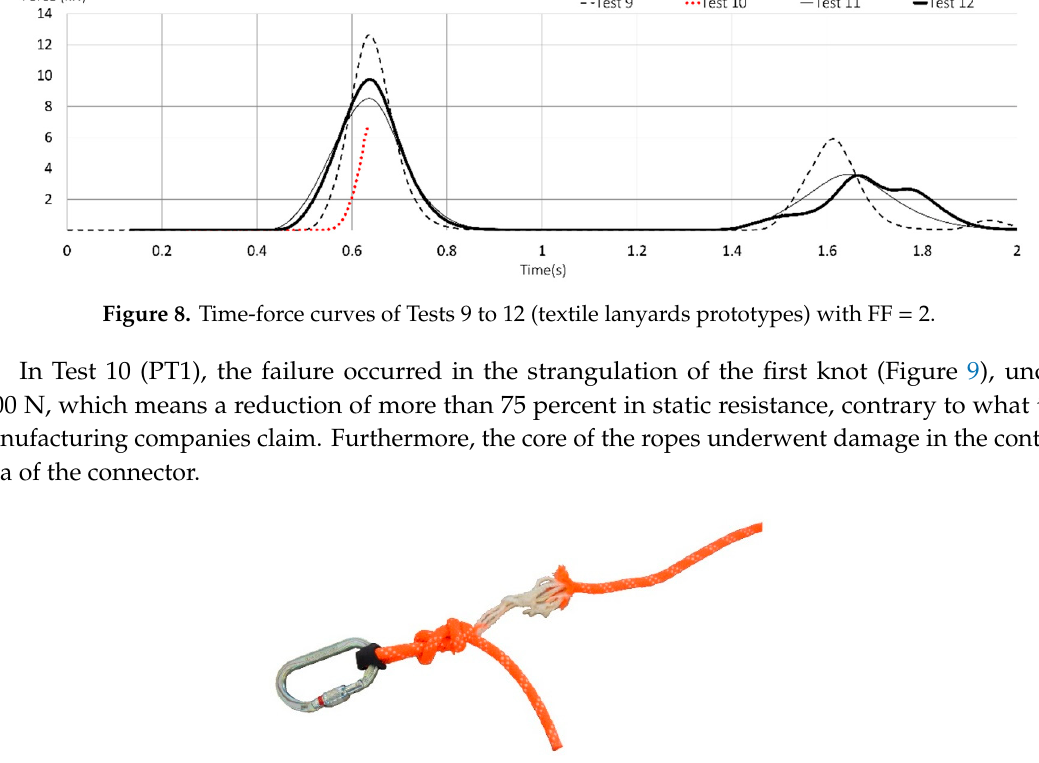
Figure 9. Failure of specimen in Test 10.